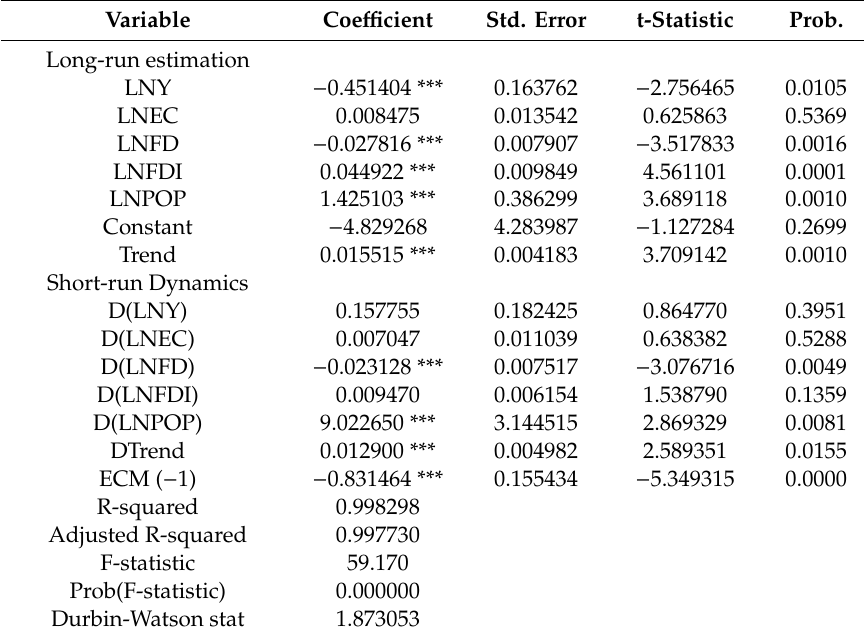
Table 9. Estimated long-run and short-run coe ffi cients of ARDL model. Variable Coe ffi cient Std. Error Prob.